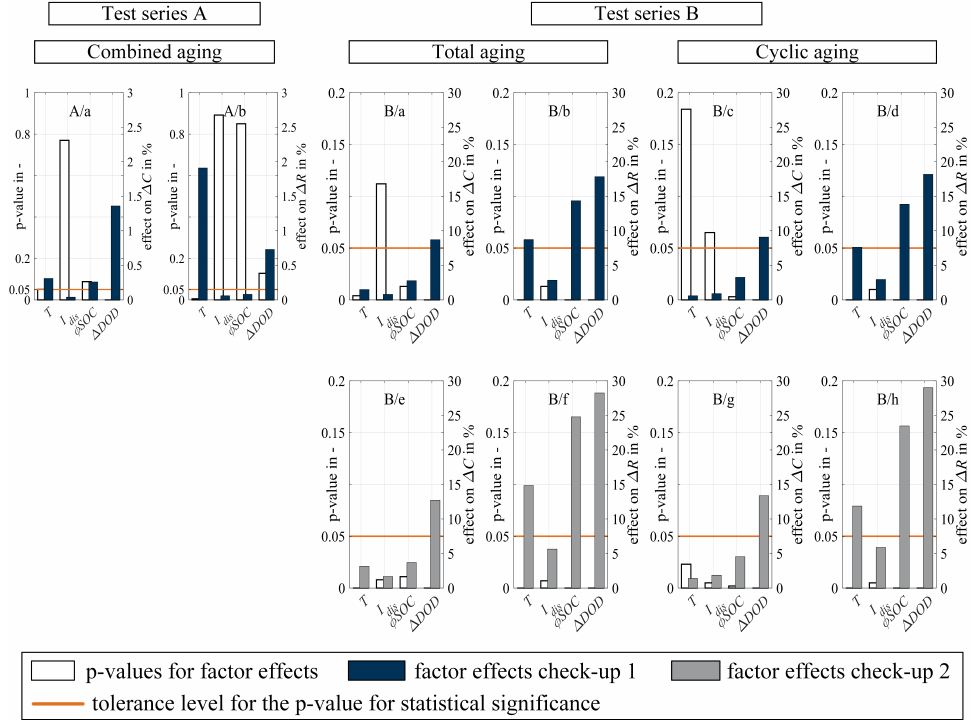
Figure 6. Sensitivity analysis on the check-up results for test series A and B: The p -values are plotted against the left y -axis with non-filled bars. The respective main effects of the stress factors T , I dis , ∅ SOC and ∆ DOD are plotted against the right y -axis with filled bars. The values are calculated using the statistical software Visual-XSel